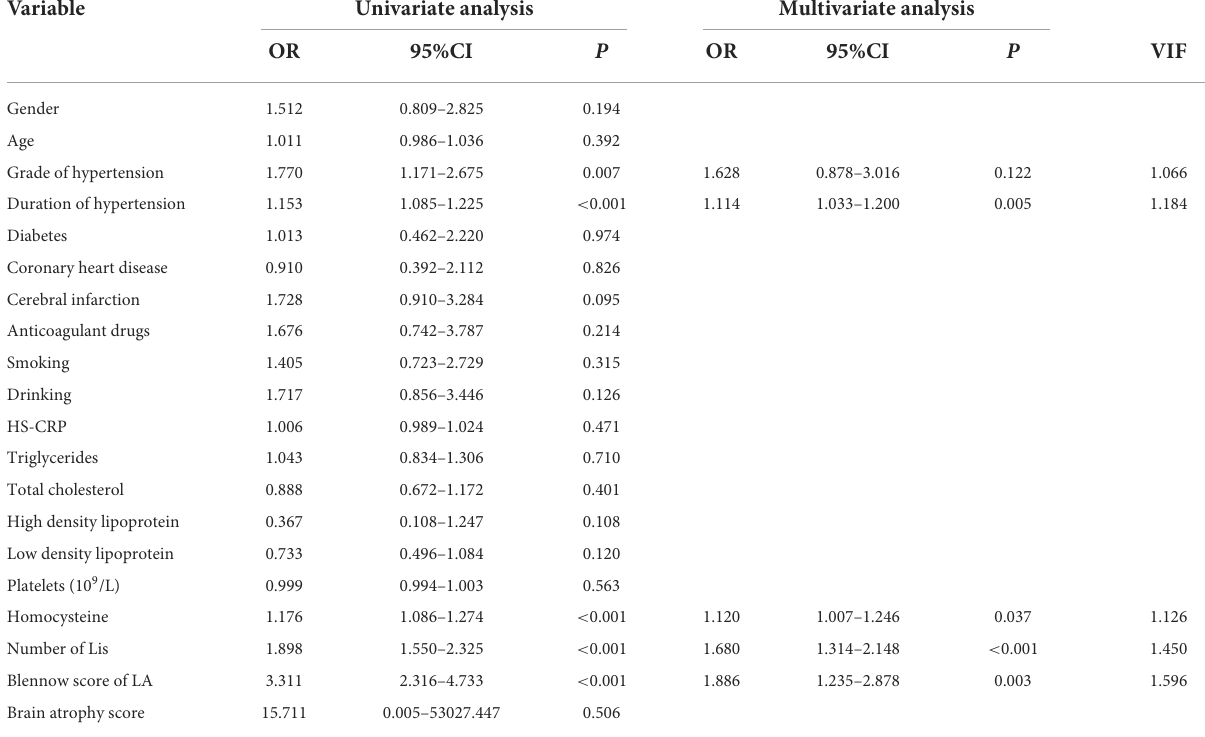
TABLE 2 Univariate and multivariate logistic regression analyses of CT and clinical characteristics. Variable Univariate analysis Multivariate analysis OR 95%CI P OR 95%CI P VIF